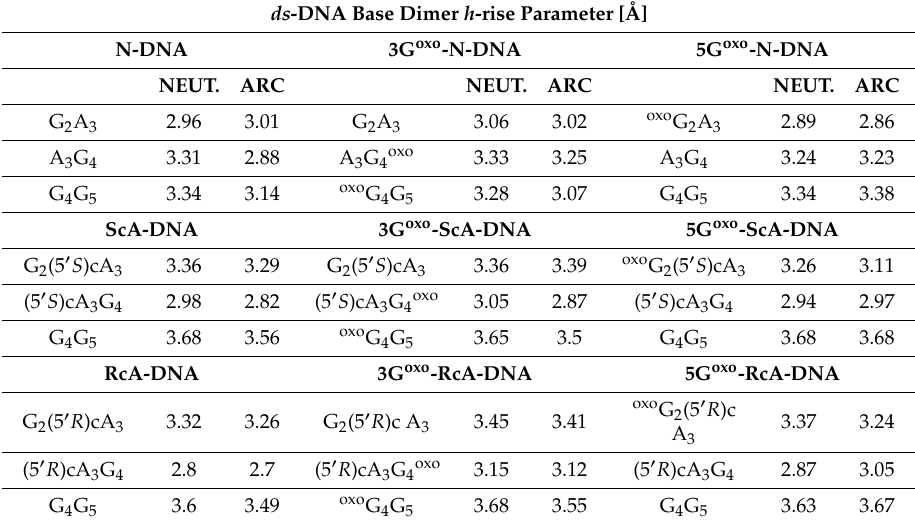
Table 2. The h -rise parameters of base pair dimers obtained for the discussed ds -oligonucleotides in their neutral (Neut.) and adiabatic radical cation (ARC) form